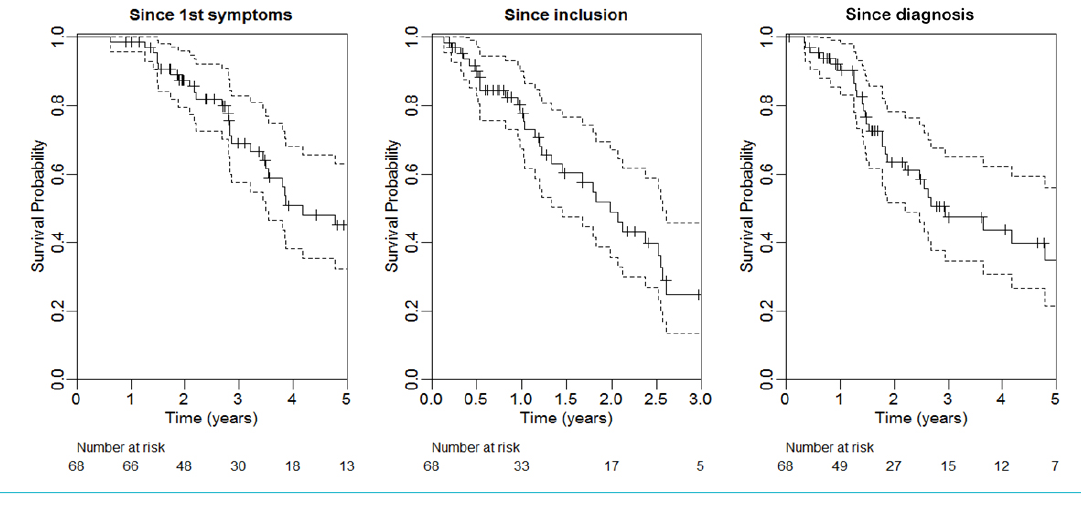
Figure 4: Cumulative incidence curves for time spent without NIV (top) and without PEG (bottom). T0: time of first symptoms (left), time of di- agnosis (middle), and time of inclusion in cohort study